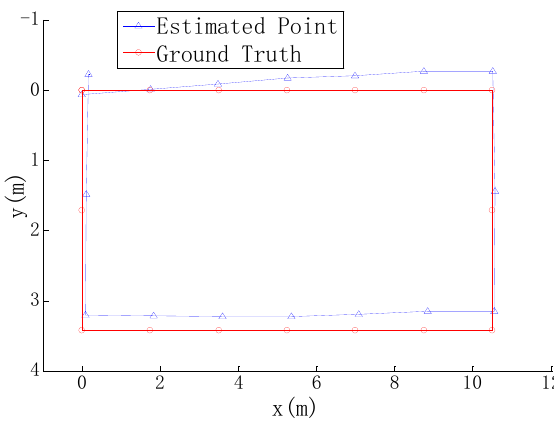
Figure 14. The comparison between estimated and real positions.